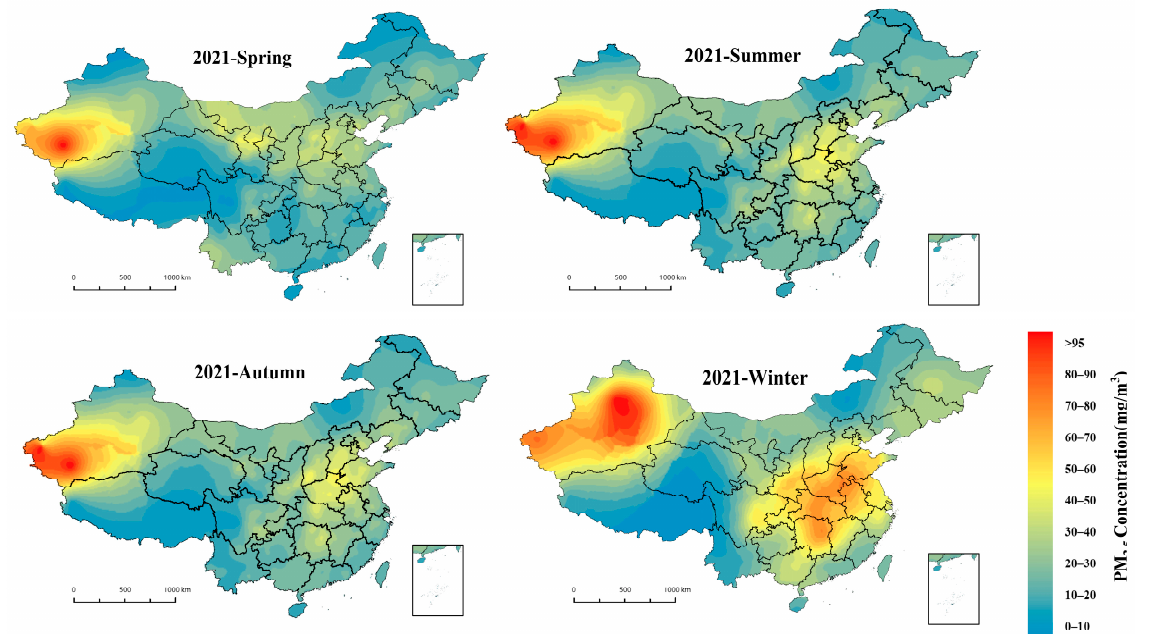
Figure 7. Spatial distribution of quarterly inversions based on the LUR ‐ GBM model for 2021.